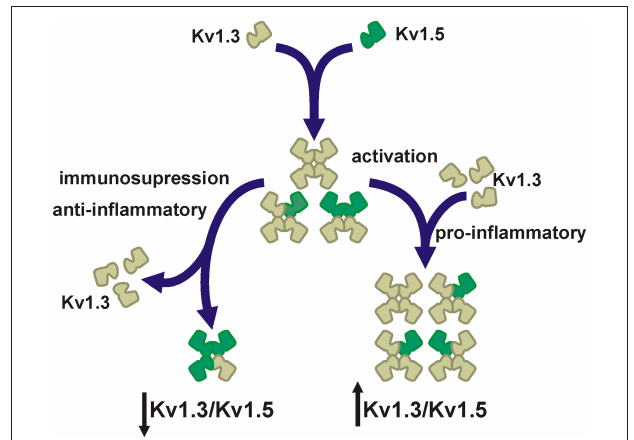
FIguRE 1 | Major Kv1.3/Kv1.5 heterotetrameric forms in mononuclear phagocytes. Cells express Kv1.3 and Kv1.5. Since most studies demonstrate that Kv1.3 blockers abolish Kv currents, Kv1.5 does not form homomeric complexes. However, molecular, pharmacological, and biophysical data indicates that cells coexpress Kv1.5 and Kv1.3. The initial ratio between Kv1.3 and Kv1.5 may vary among different cell types. Upon activation by pro- inflammatory agents (e.g., LPS or TNF- α ) cells increase the number of Kv1.3 subunits at the complex ( ↑ Kv1.3/Kv1.5). However, anti-inflammatory insults (e.g., dexamethasone) generate immunosuppression that decreases Kv1.3, which generates Kv1.5-predominant heteromeric channels ( ↓ Kv1.3/Kv1.5). Different Kv1.3/Kv1.5 molecular ratios are responsible for distinct biophysical and pharmacological properties that lead to diverse functional consequences and disperse